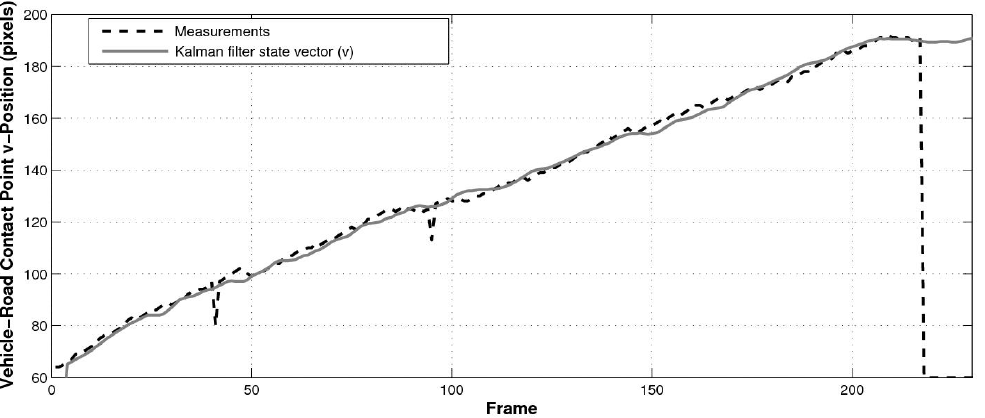
Figure 15. Estimated wheel-to-road contact point and the corresponding Kalman filter